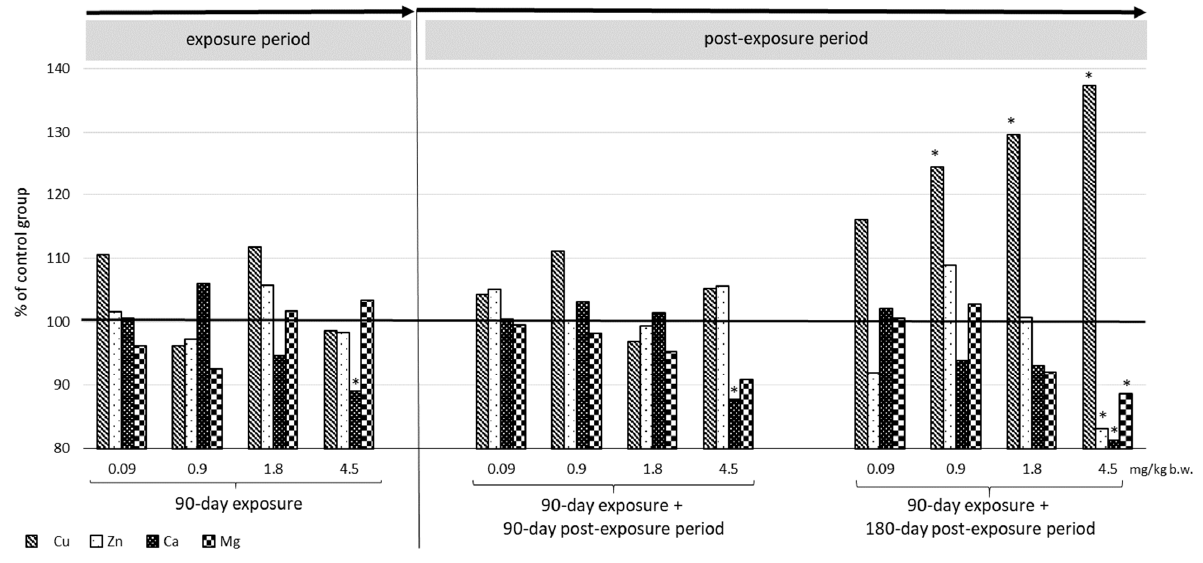
Figure 2. Changes in the concentrations of selected trace elements (Cu, Zn, Ca and Mg) in rat uterus given in % in relation to the control group (marked line 100%) after 90 ‐ day oral exposure to Cd, and after 90 and 180 days post ‐ exposure; p ≤ 0.05 (*—vs. control group).